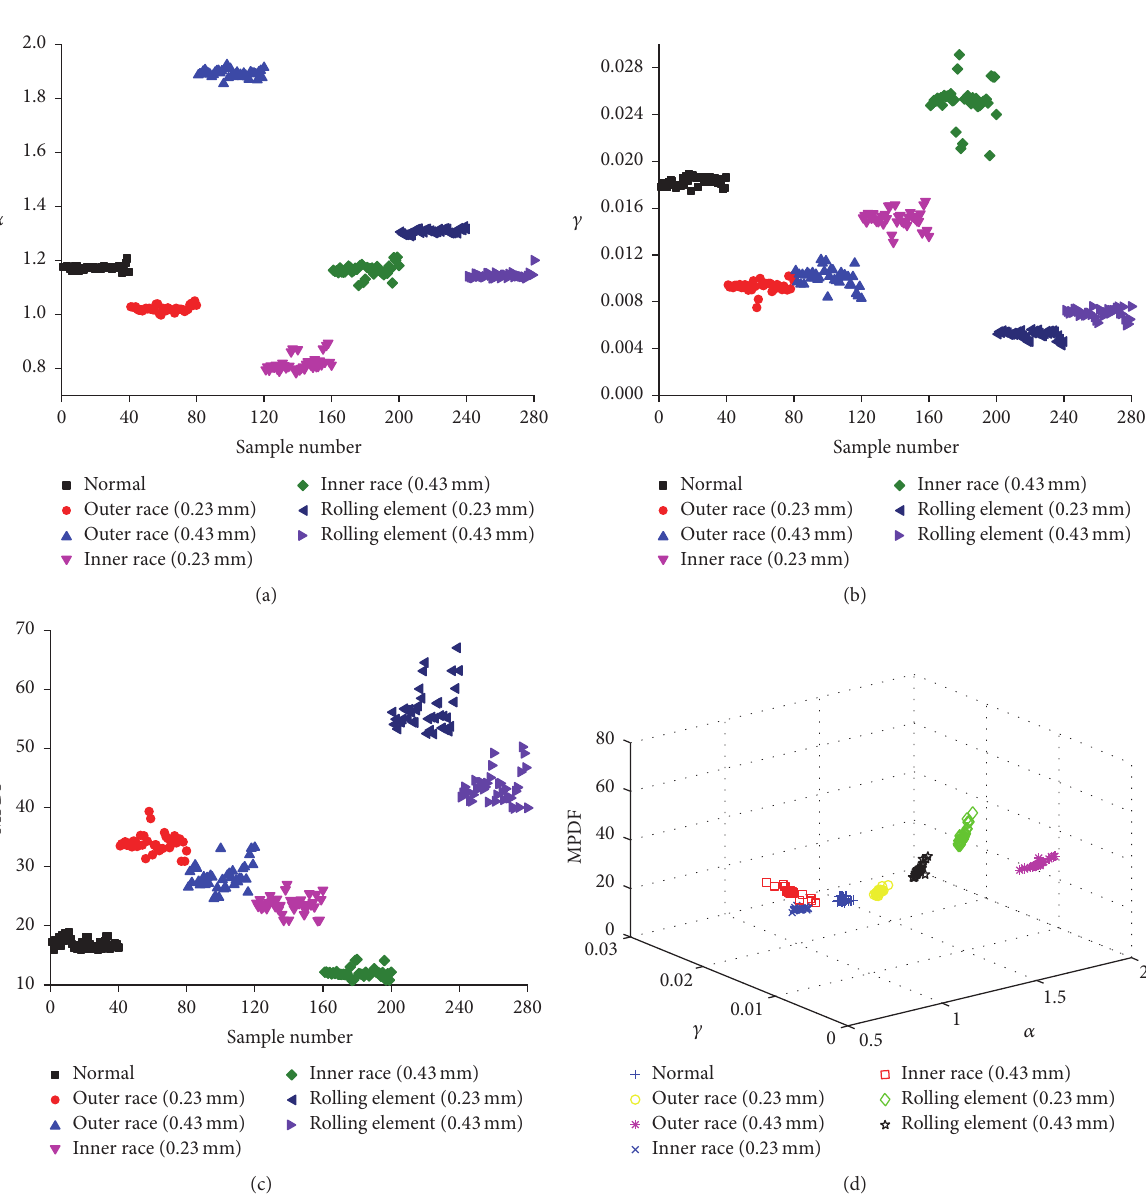
Figure 8: Illustration of S 𝛼 S features of c3: (a) 𝛼 feature parameter; (b) 𝛾 feature parameter; (c) MPDF feature parameter; (d) combined 𝛼 - 𝛾 -MPDF clustering